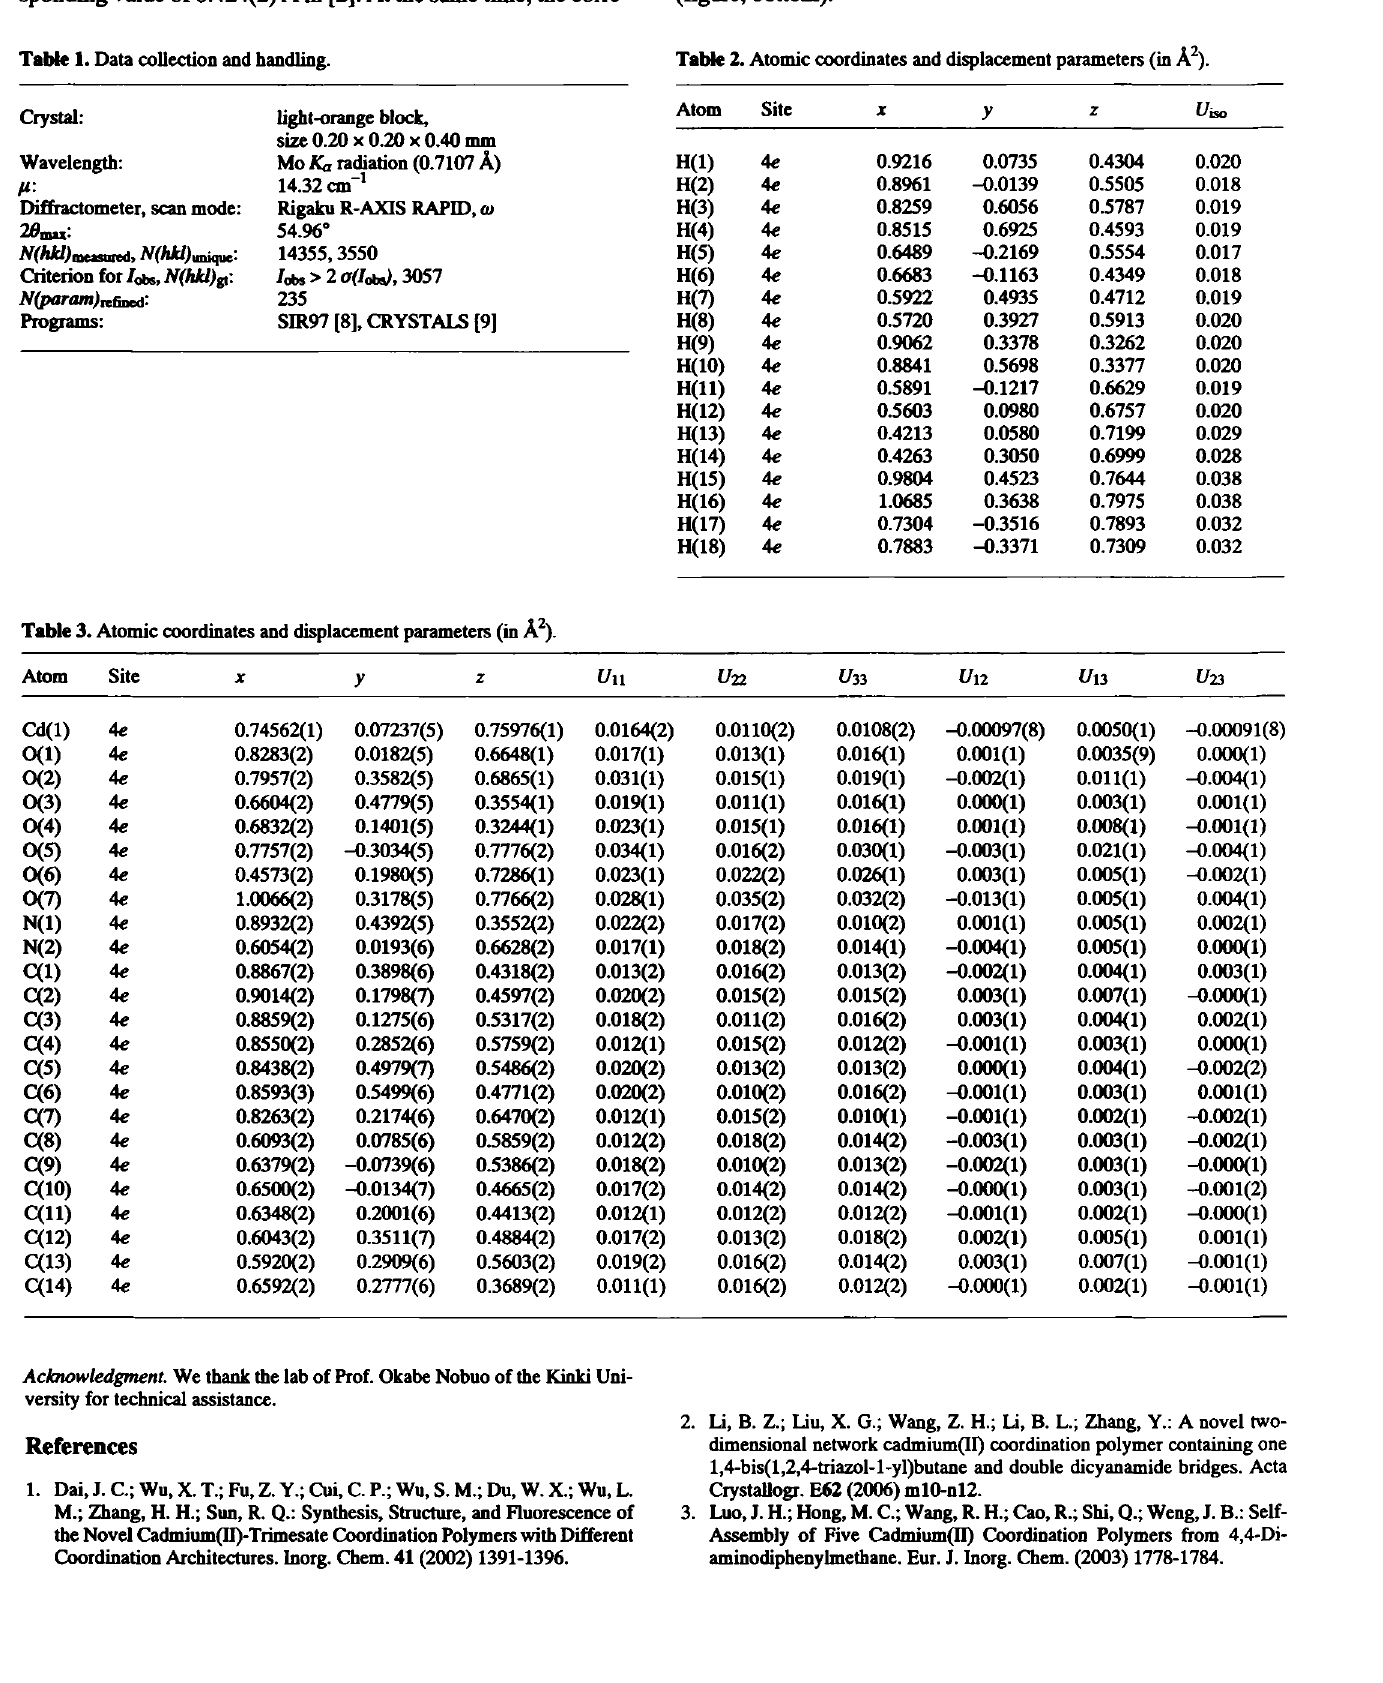
Table 3. Atomic coordinates and displacement parameters (in A 2